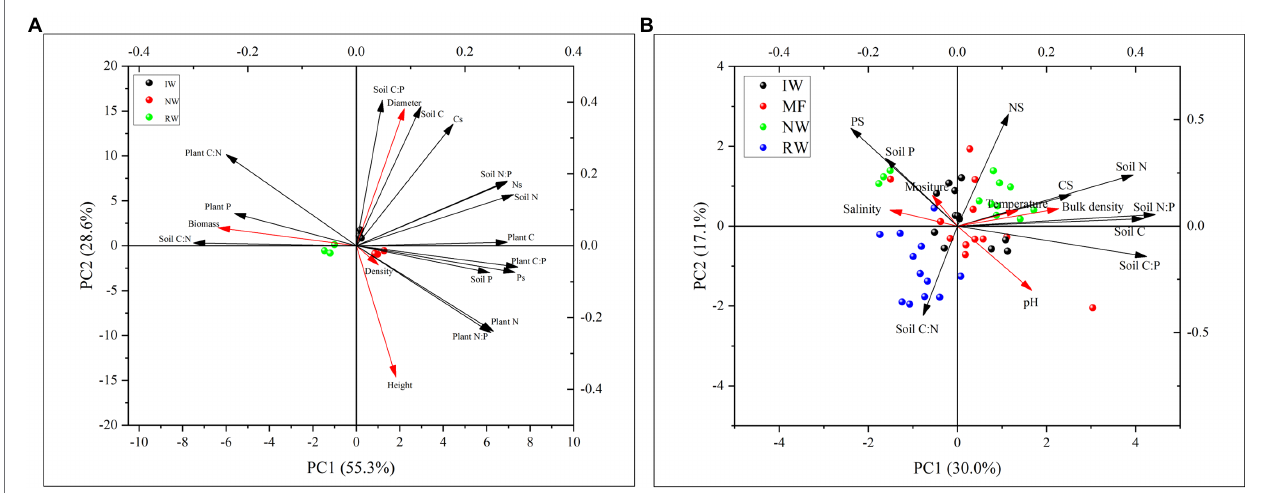
FIGURE 6 | Principal component analysis (PCA) between plant growth traits and the C, N, P stoichiometry and stocks of plants and soils in three land-use types (A) . PCA analysis between soil physiochemical properties and the C, N, P stoichiometry and stocks of plants and soils in four land-use types (B) . MF, mudflat; NW,